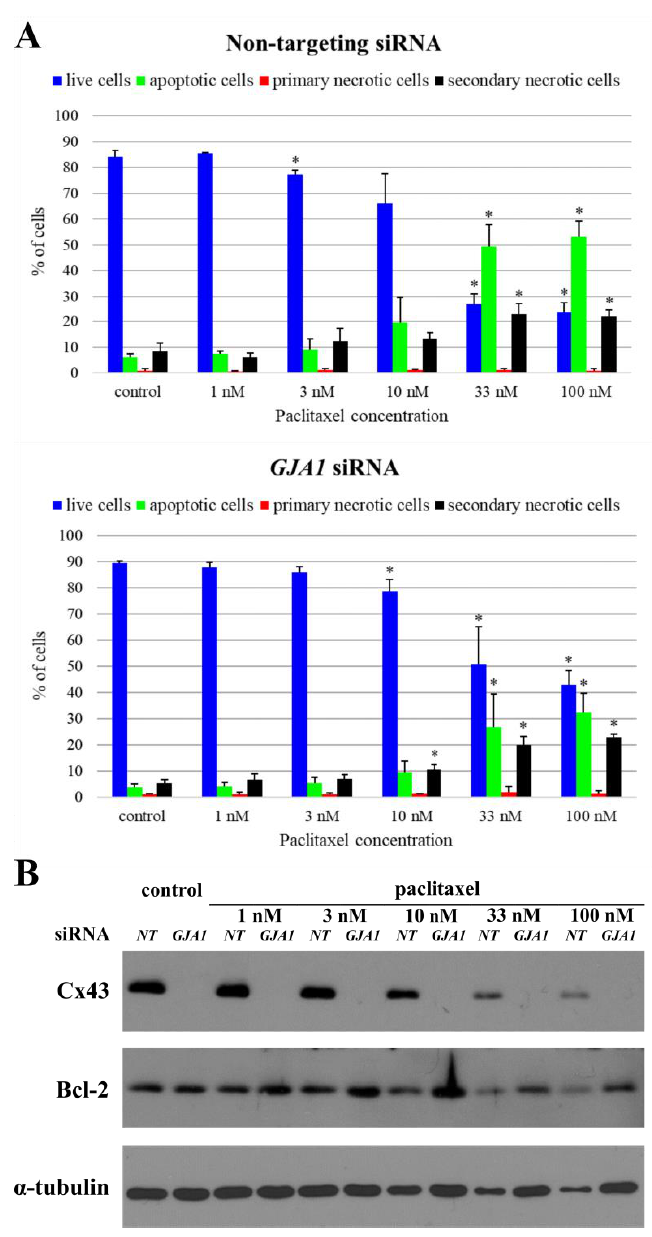
Figure 5. Changes in the paclitaxel-induced apoptosis of SCC25 after knocking down Cx43. ( A ) Annexin V-FLUOS/ propidium iodide (Ann/PI)-stained HNSCC cells were analyzed by FACS after 48 h of treatment with paclitaxel at different concentrations. Live cells are presented by the Ann-/PI- fraction, apoptotic cells by the Ann+/PI- fraction, secondary necrotic cells by the Ann+/PI+ fraction and primary necrotic cells are detected in the Ann-/PI+ fraction. Data are presented as mean ± SD. Statistical analysis was performed by Student’s t -test, the cell fractions in all concentration were compared to negative control fractions in non-targeting siRNA or GJA1 siRNA treated samples. The cell fractions in GJA1 siRNA treated samples were also compared to cell fractions in non-targeting siRNA treated samples. * p < 0.05. ( B ) Cell lysates were subjected to western blot analysis with antibodies against Cx43, Bcl- 2 and the loading control, α -tubulin. NT: non-targeting.